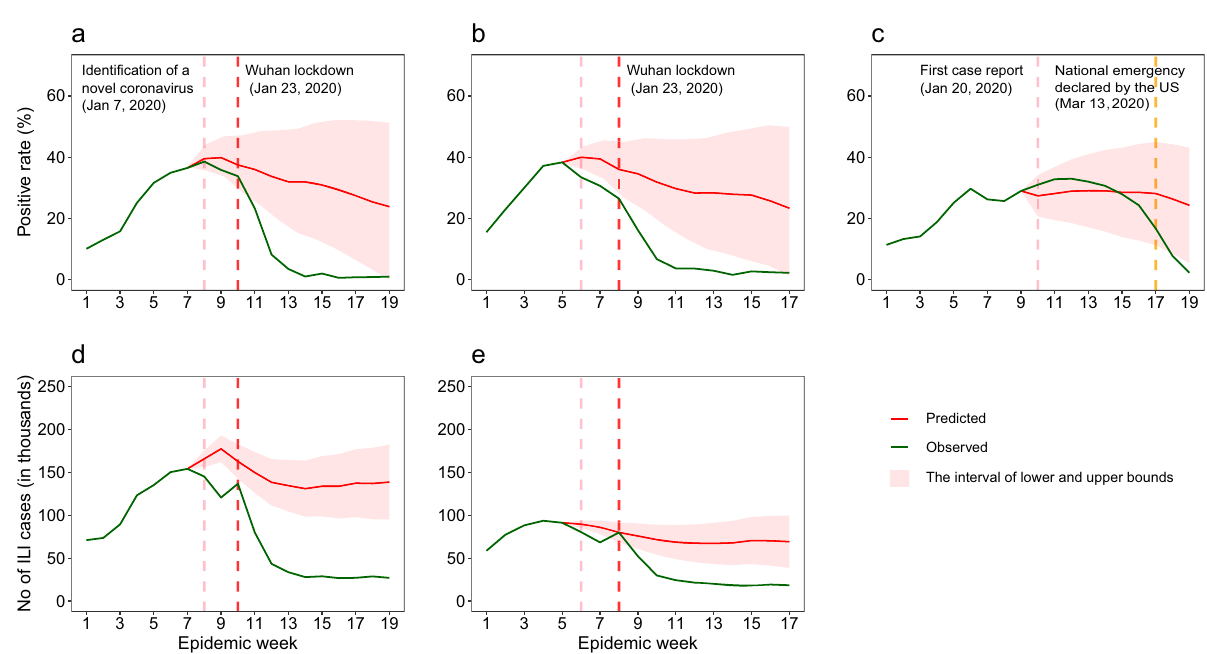
Fig. 2 Observed seasonal in fl uenza activity in mainland China and the US in 2019 – 2020, compared to estimates by ARIMA models under a counterfactual scenario of no COVID-19 and related interventions. a Positive rate of in fl uenza tests in Southern China. b Positive rate of in fl uenza tests in Northern China. c Positive rate of in fl uenza tests in the US. d Number (No.) of in fl uenza-like cases reported in Southern China. e No. of in fl uenza-like cases reported in Northern China. Lower and upper bounds of estimates are provided. The pink vertical dashed lines indicate when China ( a , b and d , e ) fi rst identi fi ed SARS-CoV-2 and the US ( c ) fi rst reported case of COVID-19. The red vertical dashed lines indicate the start of the lockdown in Wuhan, January 23, 2020. The orange vertical dashed line indicates the declaration of a national emergency by the US on March 13, 2020.